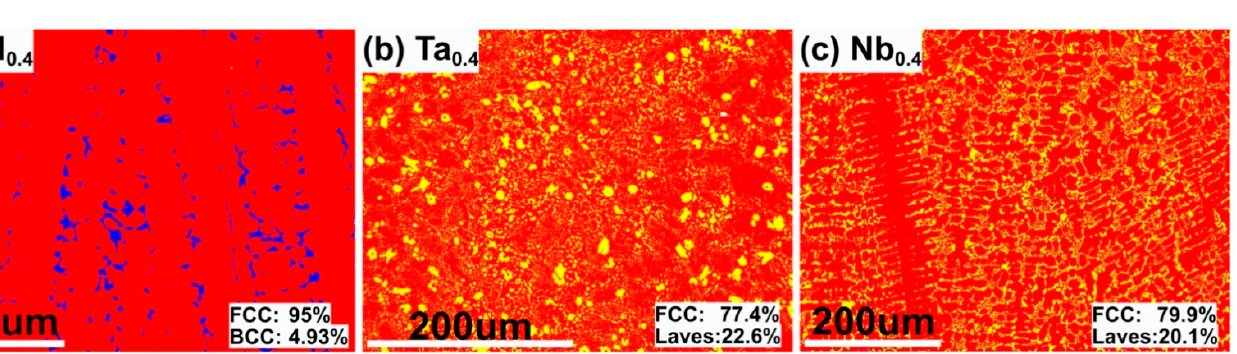
Figure 7. Grain size distribution of the CoCrFeNiX 0.4 (X = Al, Ta, Nb) HEAs prepared by PPA-AM.